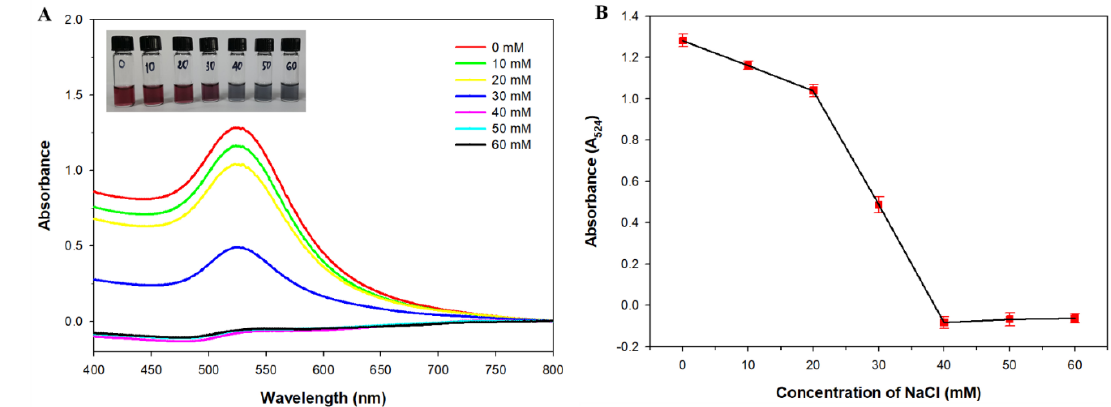
Figure 4. The UV/Vis absorption spectra ( A ) and absorbance intensity changes at 524 nm ( B ) of the gold nanoparticle (AuNP) solutions in the presence of various concentrations of NaCl. Inset: visible color changes of the AuNP solutions.